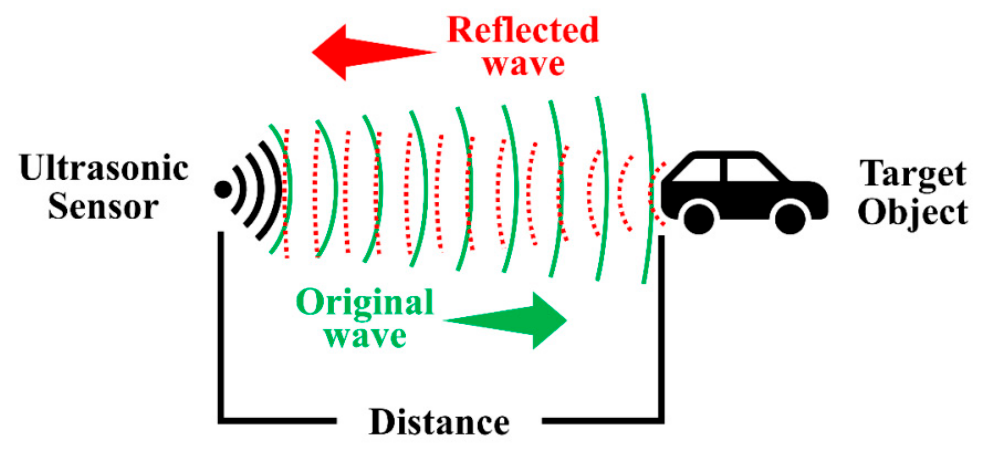
Figure 10. Echolocation used by ultrasonic sensors.